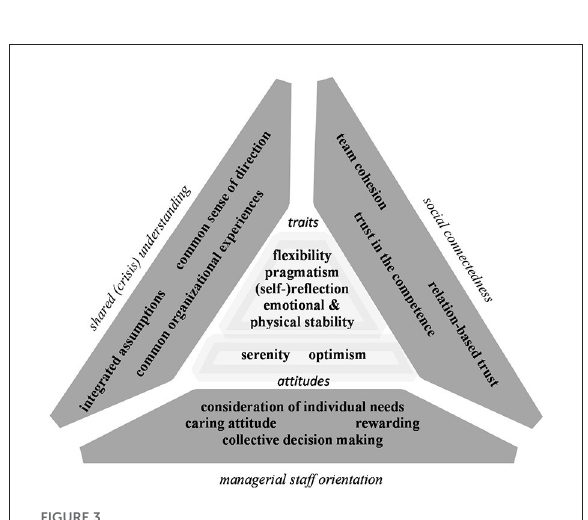
FIGURE3 Framework of individual-based and interactional resilience mechanisms (own